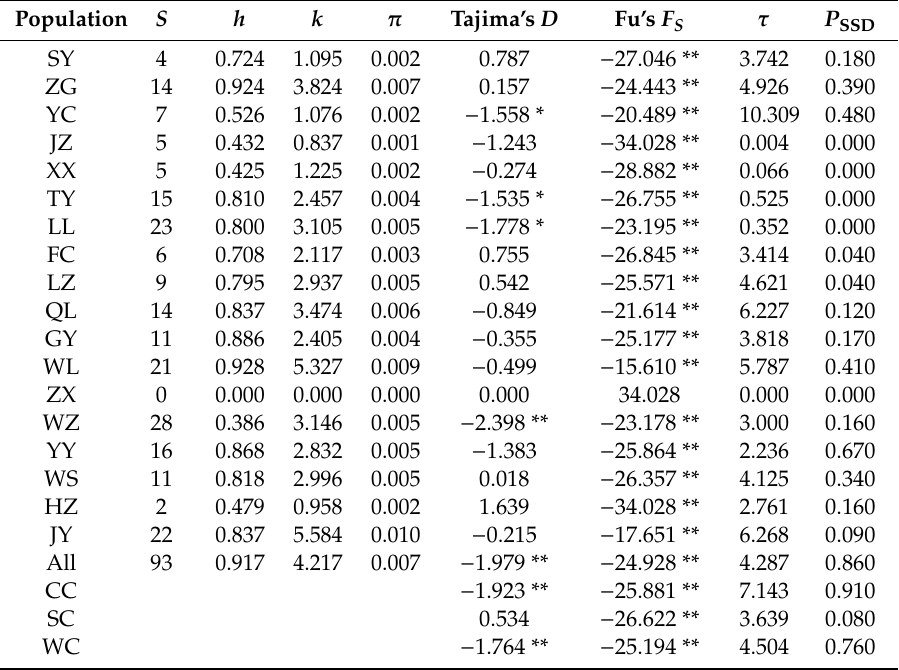
Table 2. Parameters of genetic diversity of nad4 .